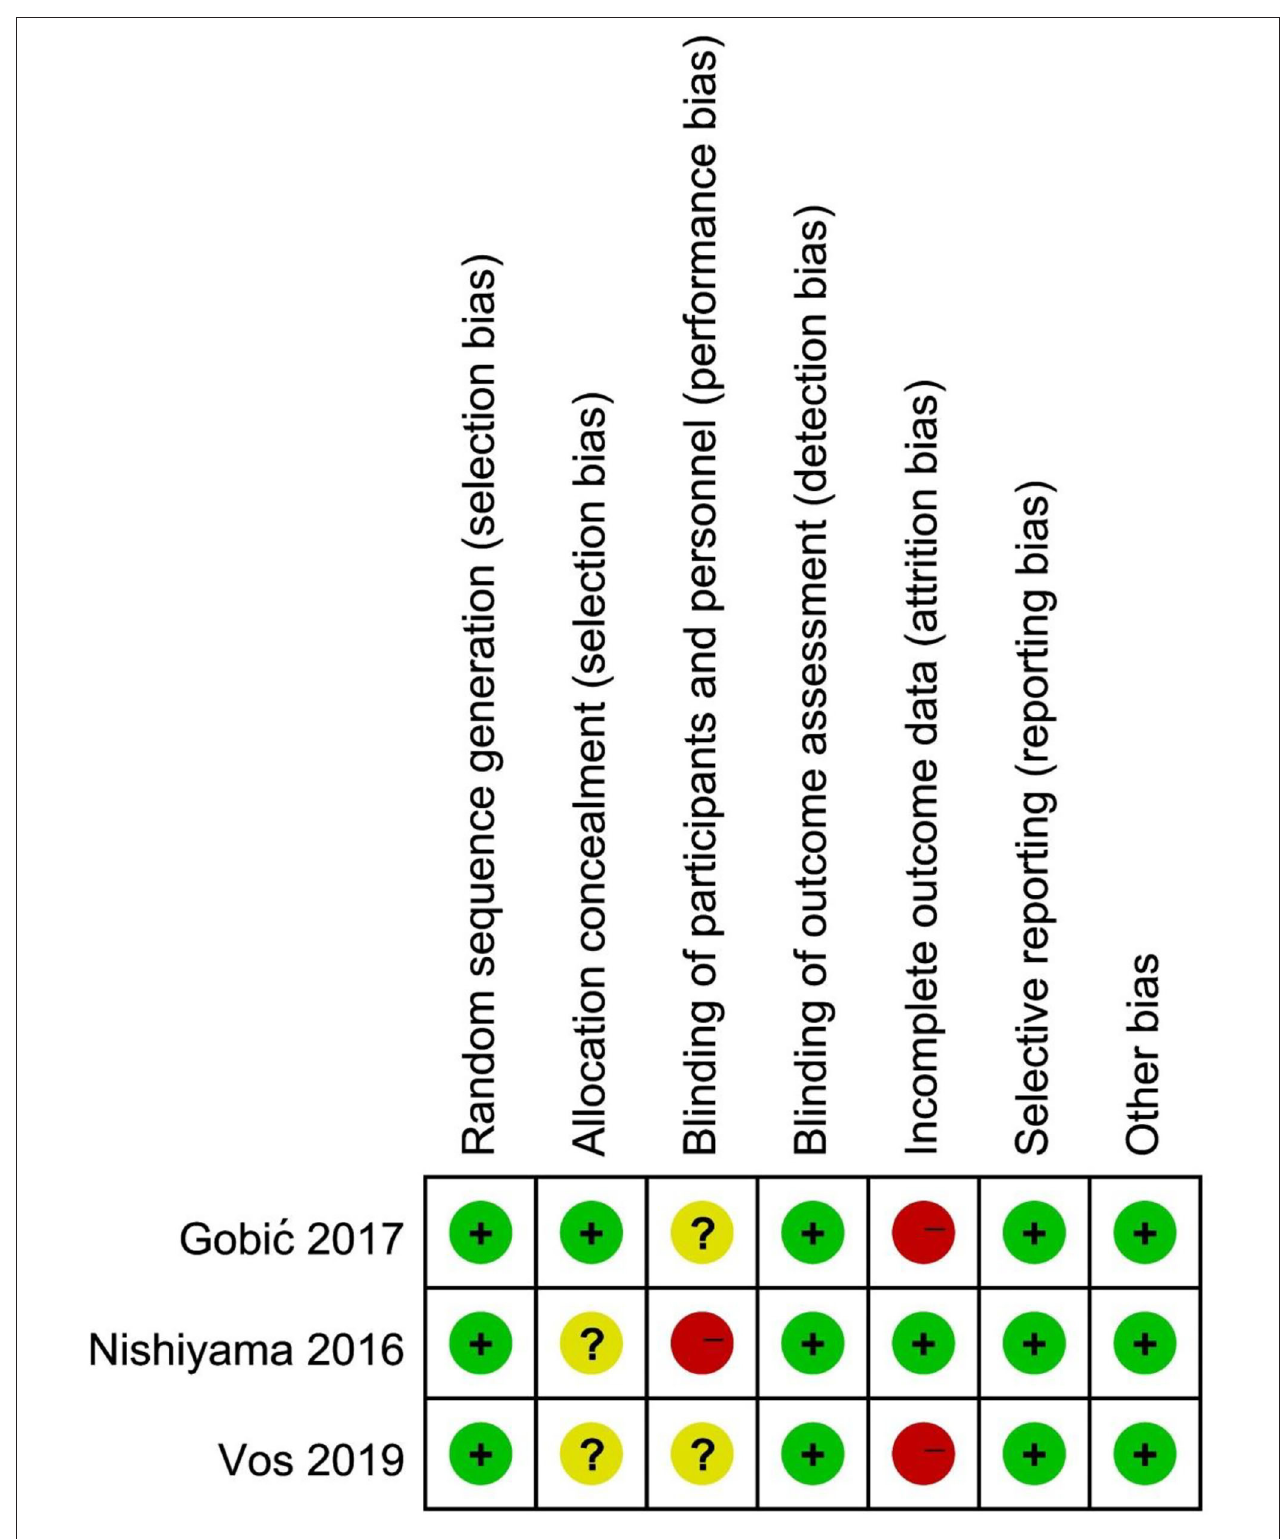
FIGURE 3 | Risk of bias summary review authors’ judgements about each risk of bias item for each included RCT.